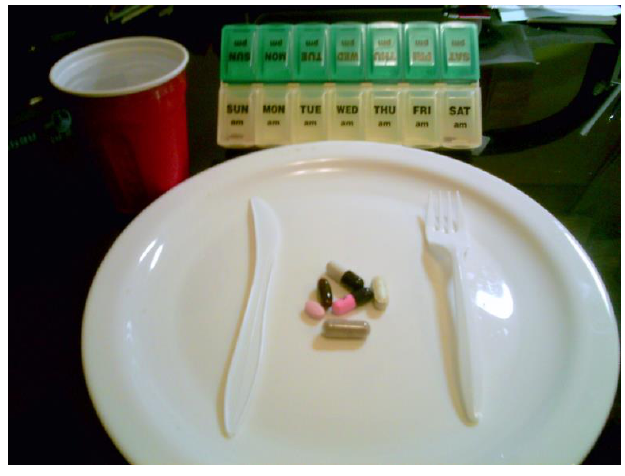
Figure 5. Plate of pills.